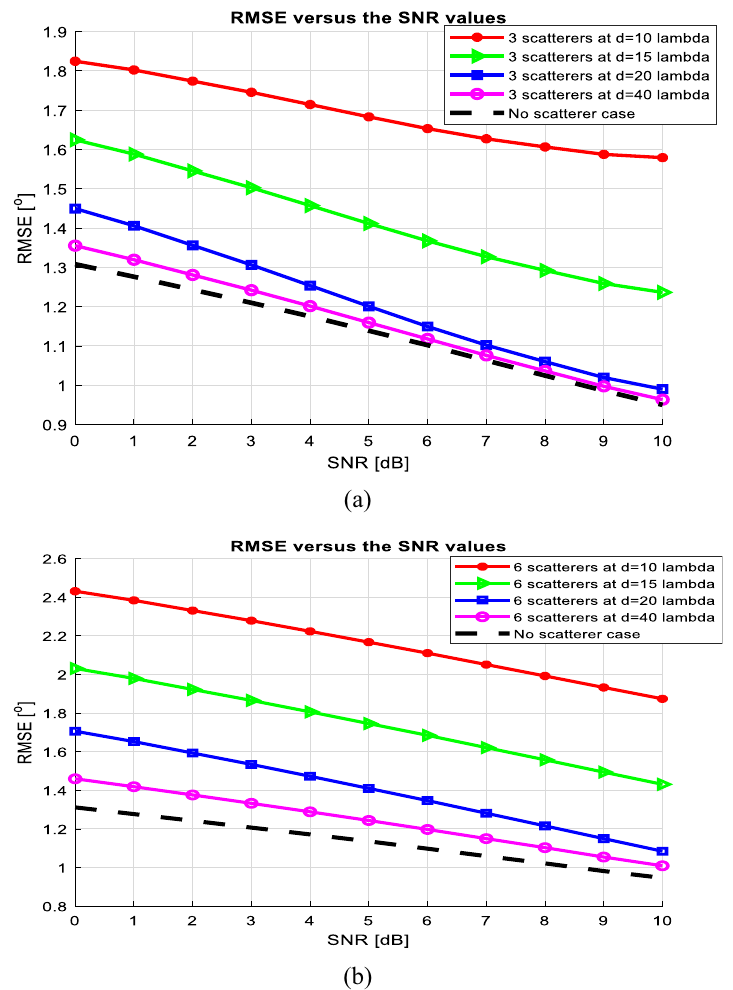
Fig. 13 RMSE values versus the SNR using the geometry of Fig. 11 in presence of far-field scatterers at d = 10 (cid:31) ,15 (cid:31) ,20 (cid:31) ,40 (cid:31) distances compared to no scatterer case, at fixed number of snapshots( L large cylindrical scatterers, b six large cylindrical